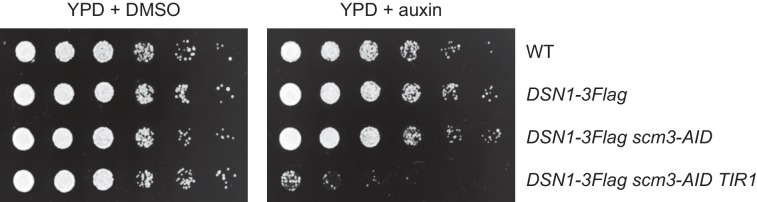
Degradation of HJURPScm3 is lethal to cells.The Scm3-AID protein is degraded in the presence of both auxin and OsTIR1, resulting in lethality. Saturated cultures were serial diluted and plated on the indicated media. The strains used are WT (SBY4), DSN1-3Flag (SBY14441), DSN1-3Flag scm3-EGFP-AID (SBY16440), and DSN1-3Flag scm3-EGFP-AID OsTIR1-myc (SBY16438).